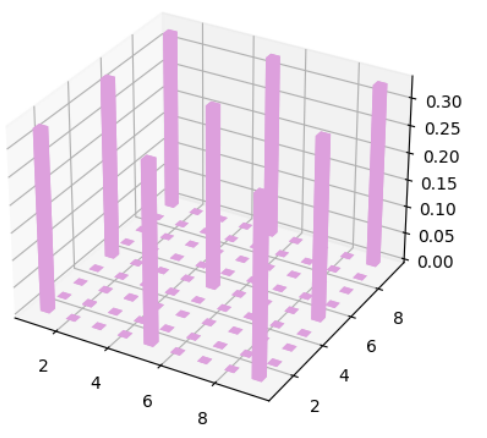
Figure 6. Density matrix when α =